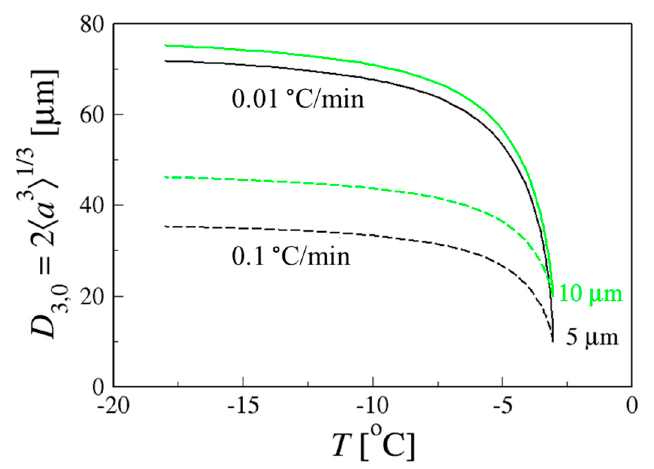
Figure 6. Volumetric mean diameter D 3,0 calculated for ice crystals in 30 wt% sucrose solution, cooled at a rate of 0.01 ° C/min (full curves) and for 0.1 ° C/min (dashed curves), starting at 5 (black) and 10 (green) μ m radius.